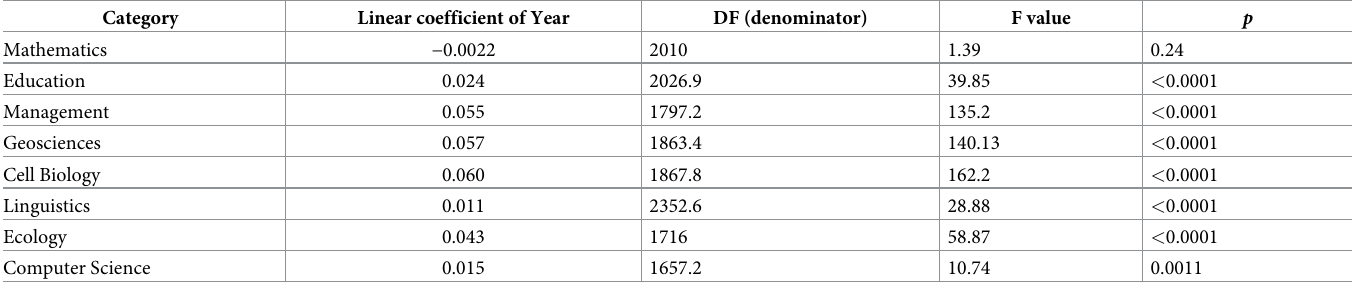
Table 2. Statistical results for linear mixed-effects models testing the increasing trend in the number of references per page in eight disciplinary categories from 1980 to 2002.